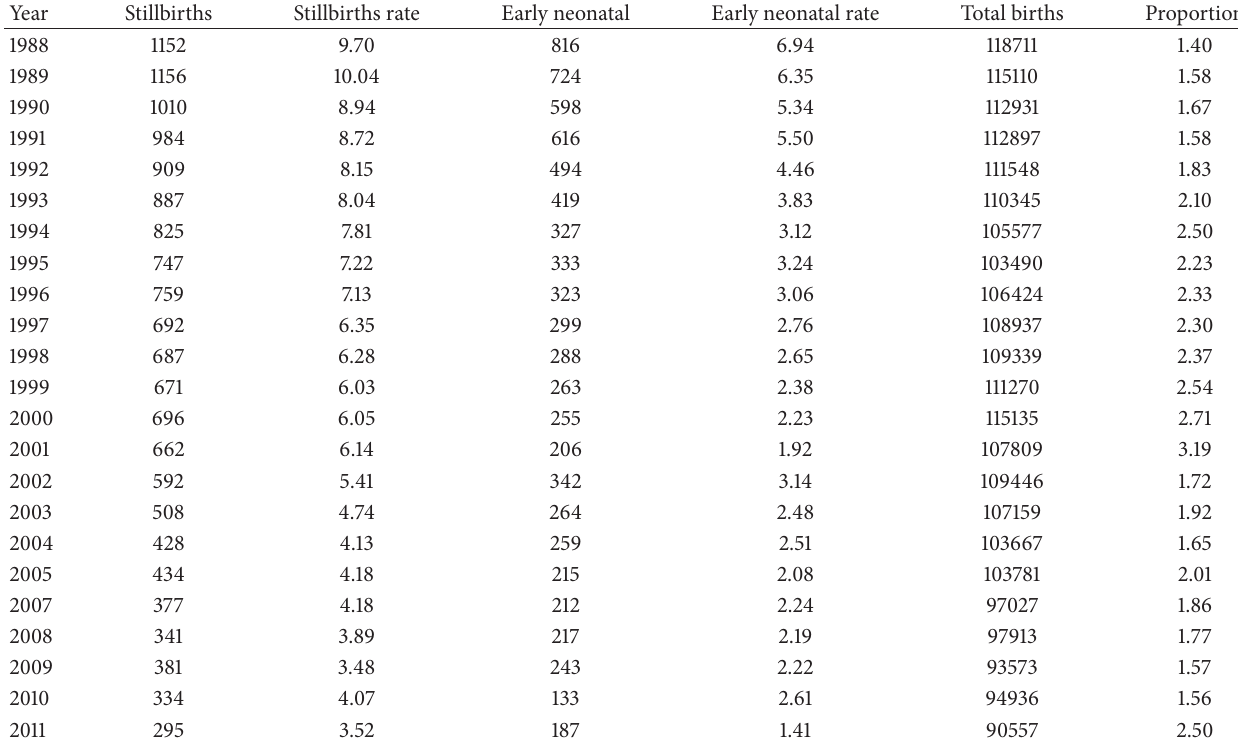
Table 1: Yearly frequency of stillbirths, early neonatal deaths, and total births. Rates of stillbirths and early neonatal deaths. Proportion stillbirth rate/early neonatal